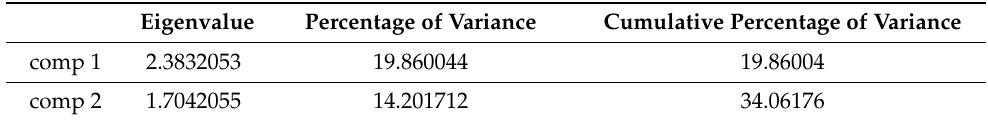
Table 5. Principal components eigenvalues.